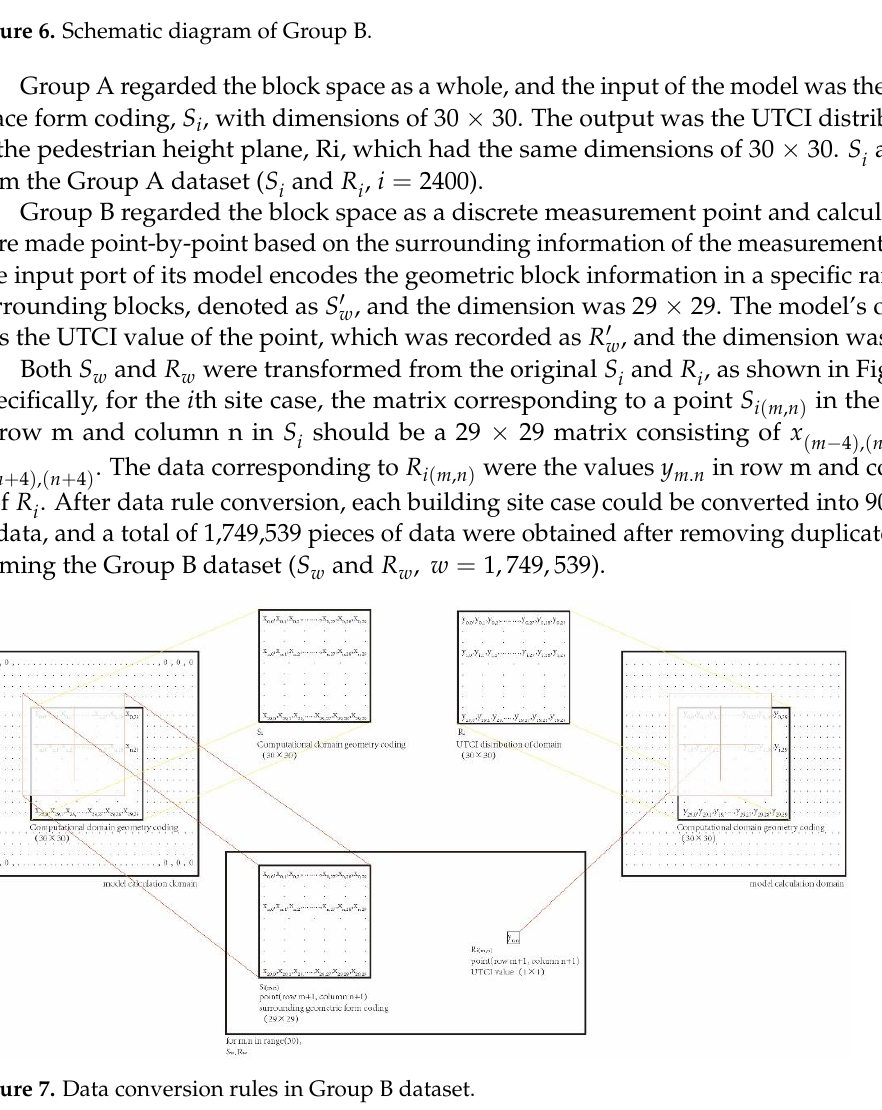
Figure 6. Schematic diagram of Group B.